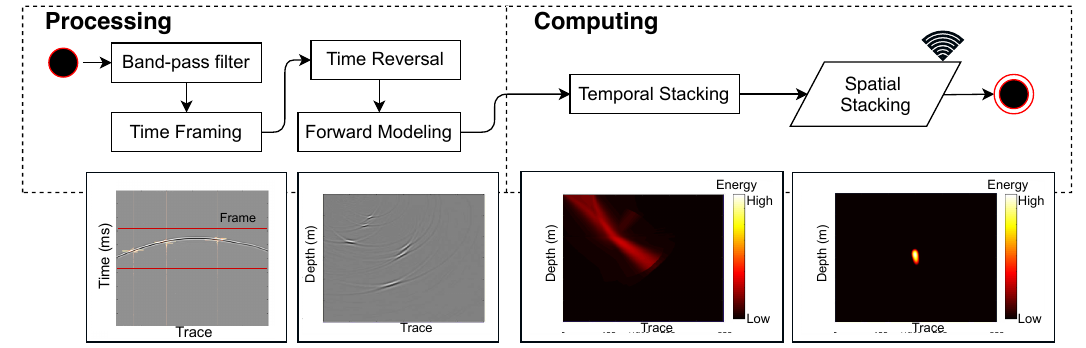
Figure 6. Processing and computing algorithm flows of seismic migration imaging. The wireless sign in the figure means communication between nodes is